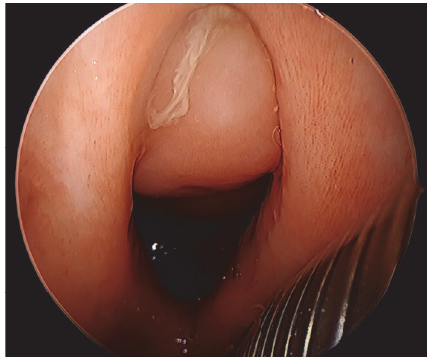
Figure 1: Endoscopic view of teratoma extending into the oropharynx. Transoral endoscopic view of a large mucosalized mass extending from the nasopharynx into the upper aspect of oral cavity and pharynx and occluding the cleft palate defect. The metal rings represent the reinforced endotracheal tube placed transorally following induction of anesthesia.